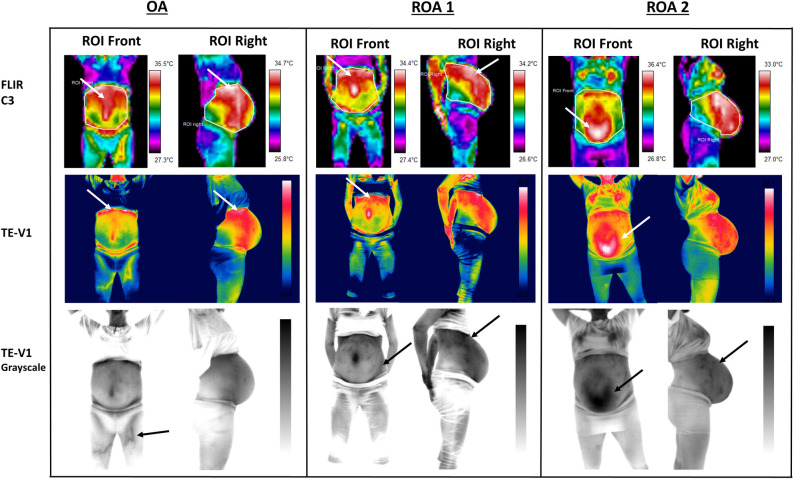
Representative qualitatively analysed thermal images of three women who did not experienced any fetal movements during and/or after the assessment.In all three cases the fetus was closer to the right side, which presented warmer-red regions related to the fetal position/location.